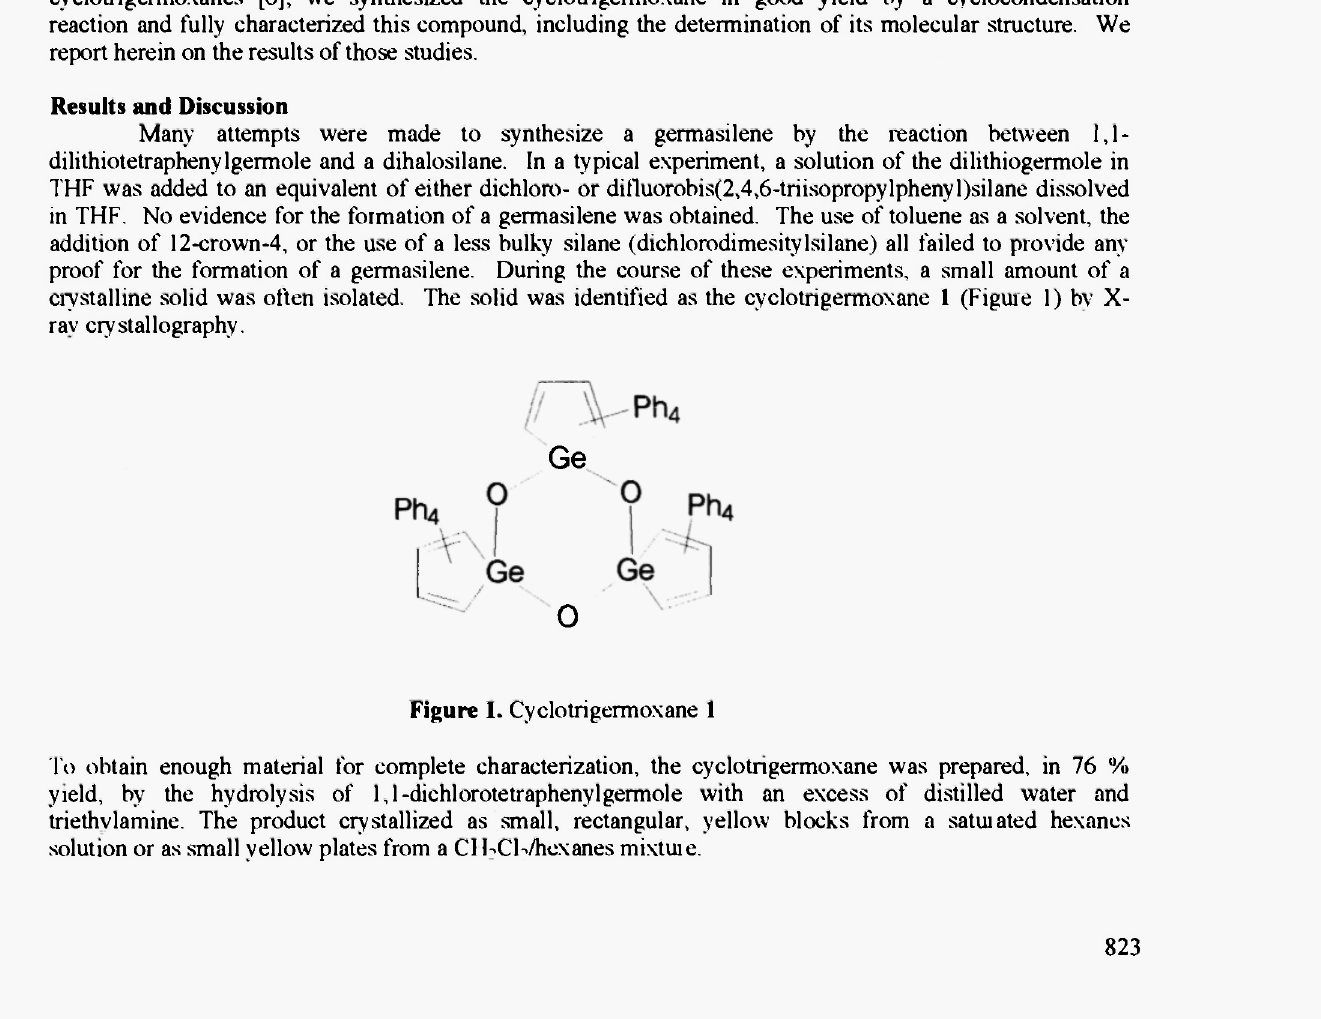
Figure I. Cyclotrigermoxane